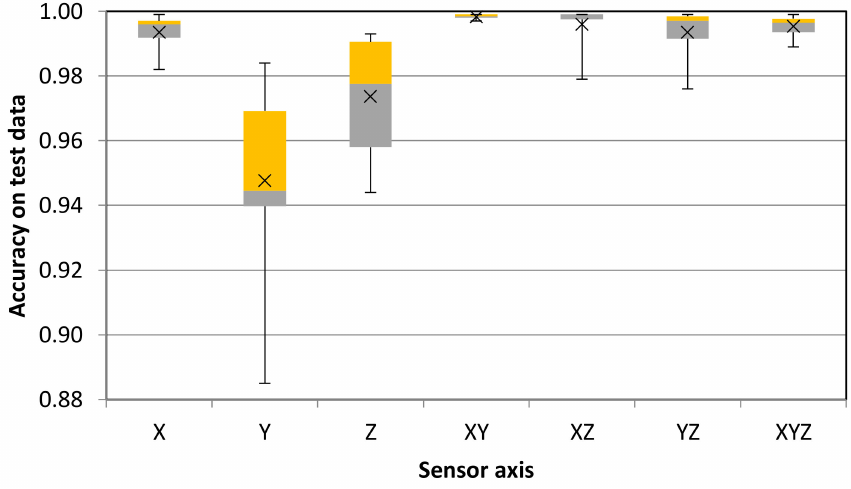
Figure 23. Box plot of ‘accuracy on test data’ for all sensor axis of the accelerometer.